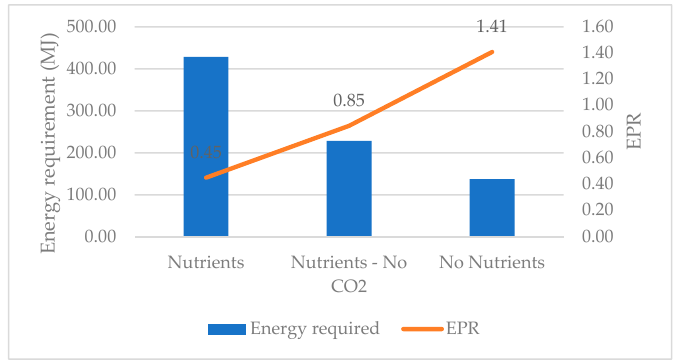
Figure 7. Energy profit ratio with nutrients and nutrients removed.